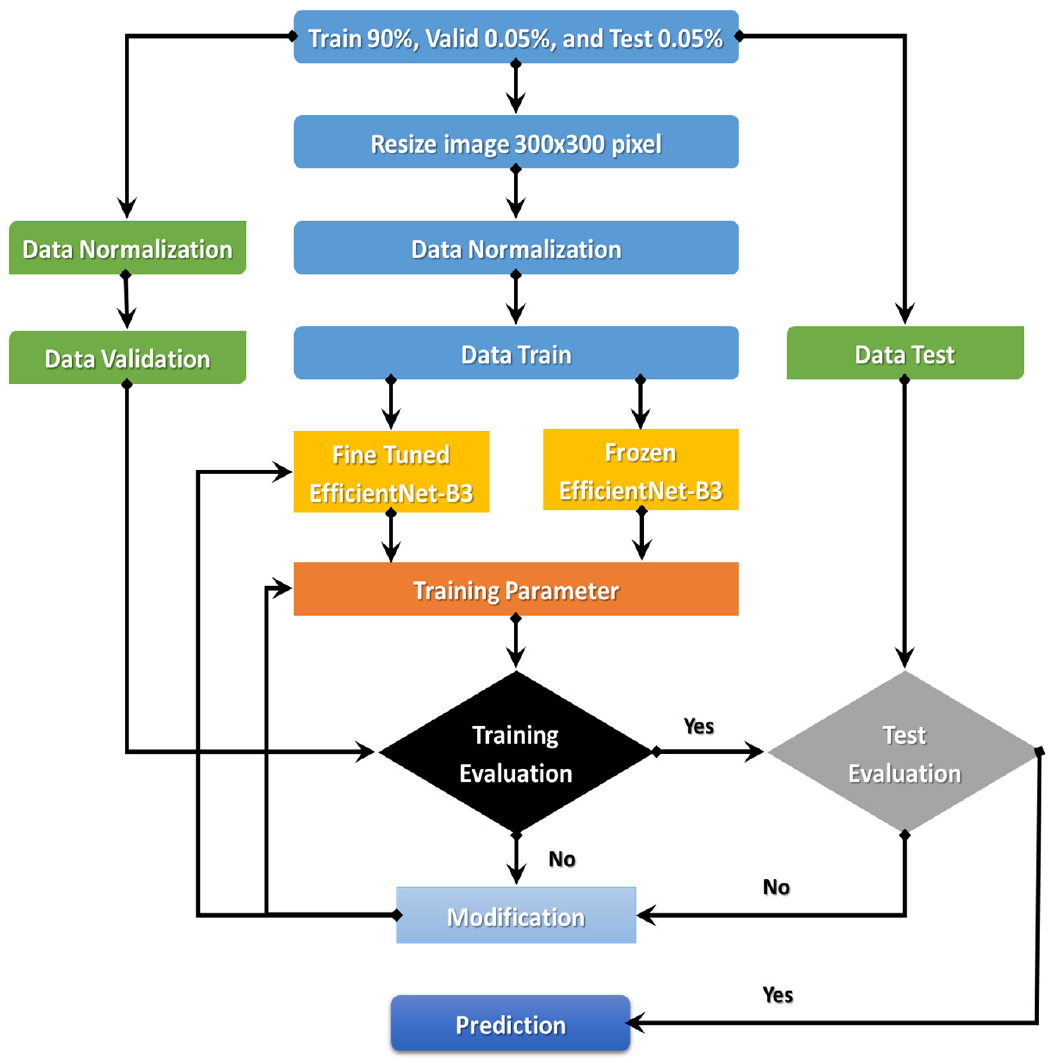
Figure 3. Flowchart of the proposed model.